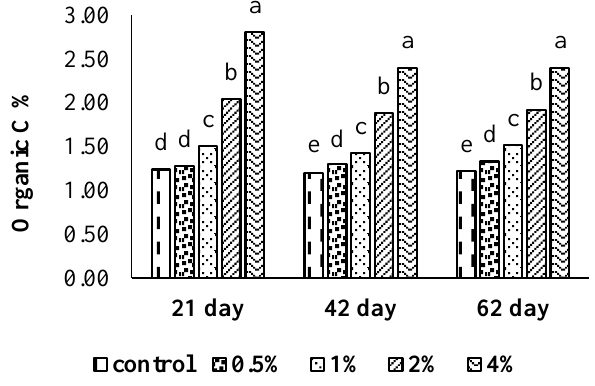
Figure 4. Effects of different rates of HA applications on soil or- ganic carbon.